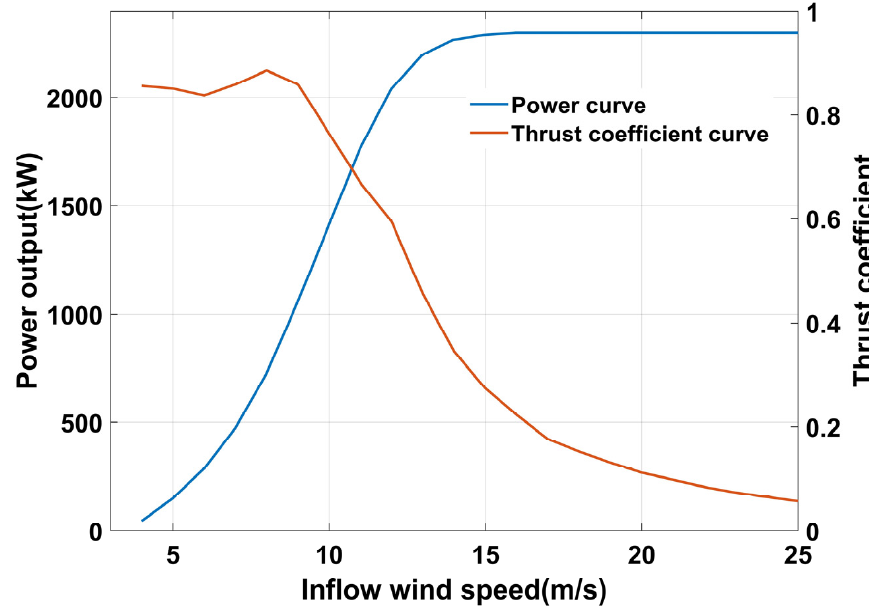
Figure 7. Power curve and thrust coefficient curve from Bonus 2.3 MW .